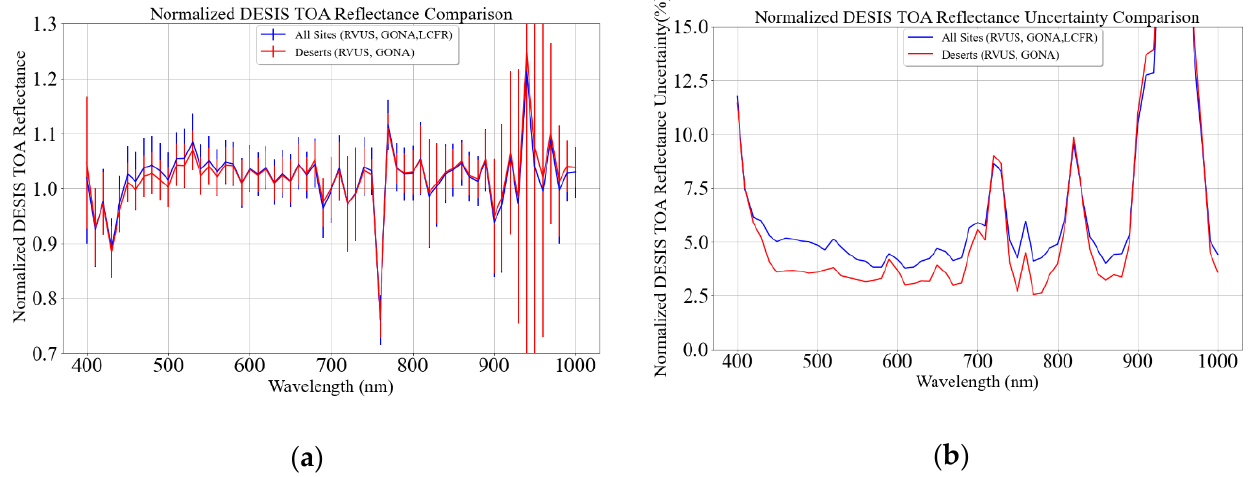
Figure 18. Mean of normalized DESIS TOA reflectance using different sites ( a ) and its corresponding uncertainty ( b ).